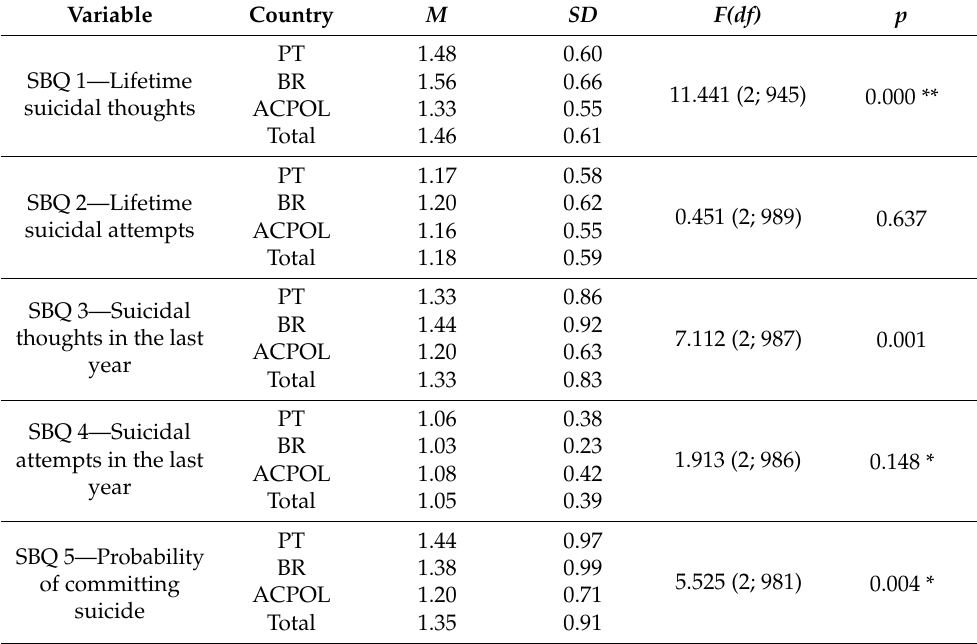
Table 4. Differences in suicidal behavior by country of